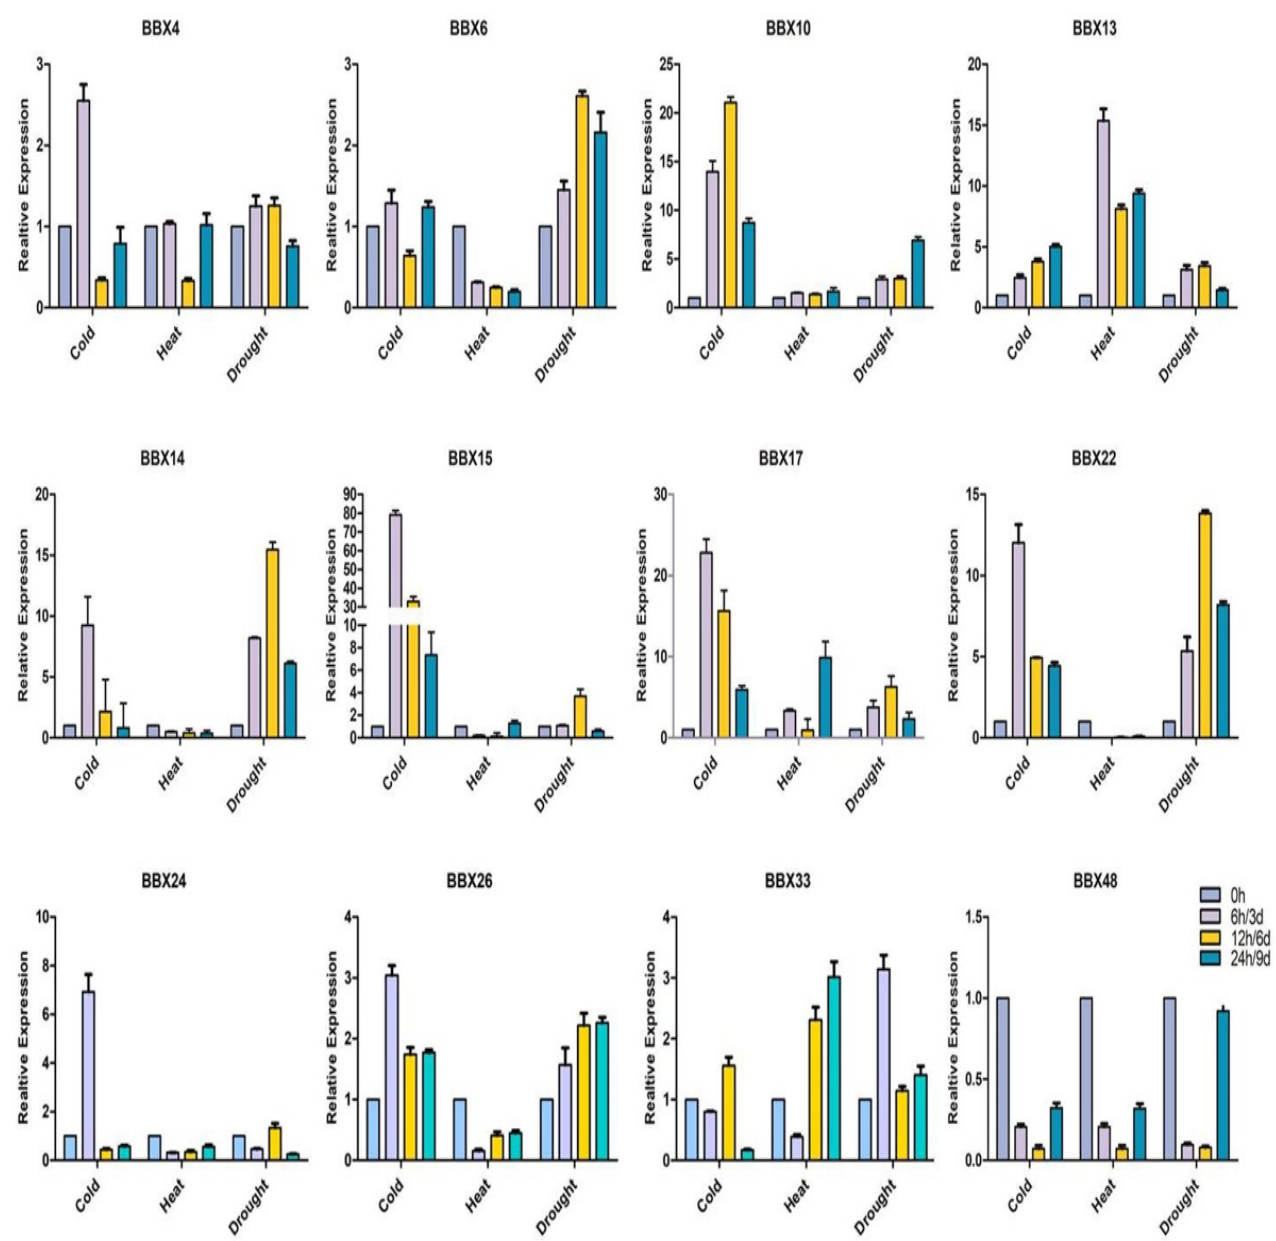
Figure 11. Inducible expression profiles of Brassica BBX genes in response to cold, heat, and drought conditions. The x -axis presents the treatments. The y -axis presents the expression levels relative to the expression at the 0-h time point. Error bars indicate the standard deviations of three independent qRT-PCR biological replicates.